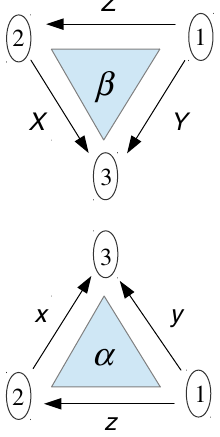
FIG. 1. This figure shows six Majorana zero modes arranged in two qubits consisting of three MZMs each, with pairs corre- sponding to the x , y , and z axes of each qubit labeled. An arrow designates the definition of the corresponding Pauli operator in terms of the MZMs. For example, σ